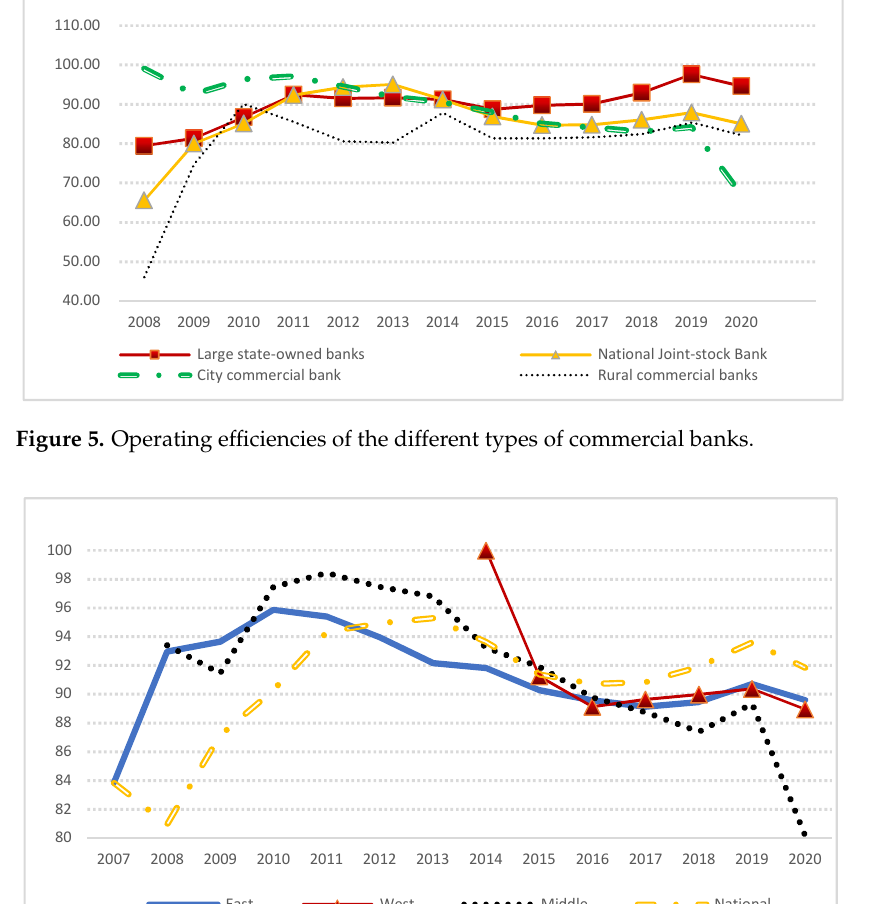
Figure 6. Operating efficiencies of commercial banks in different regions.